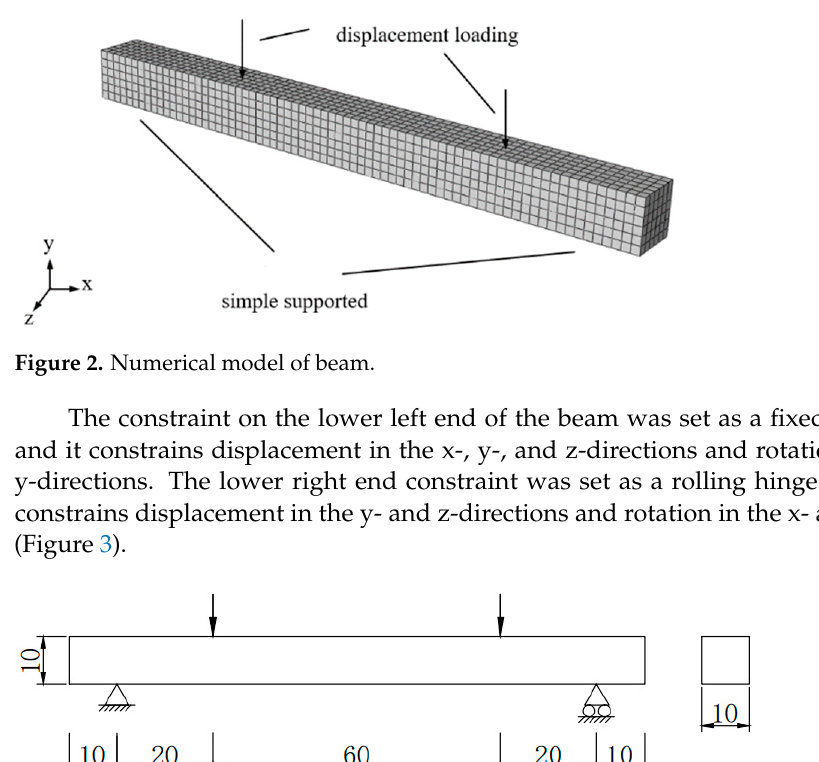
Figure 3. Dimension and constraints of the beam (cm).